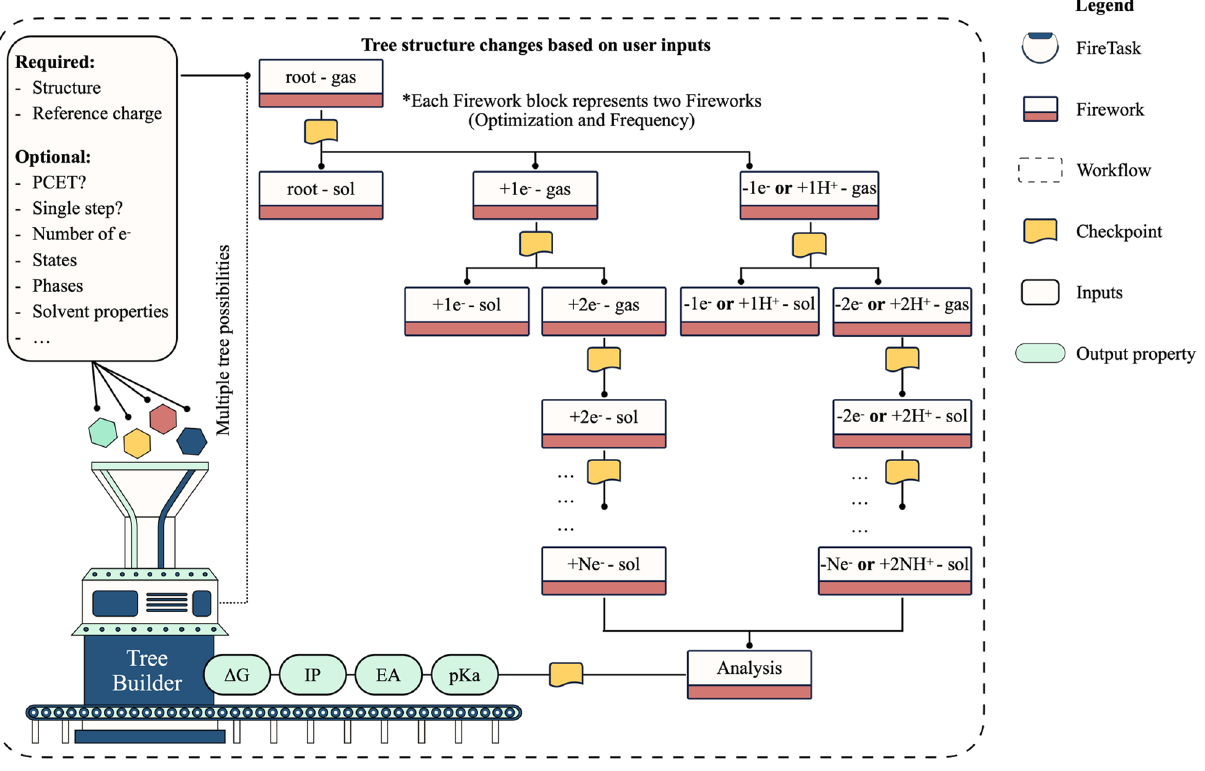
Figure 7. Workflow diagram for redox potential